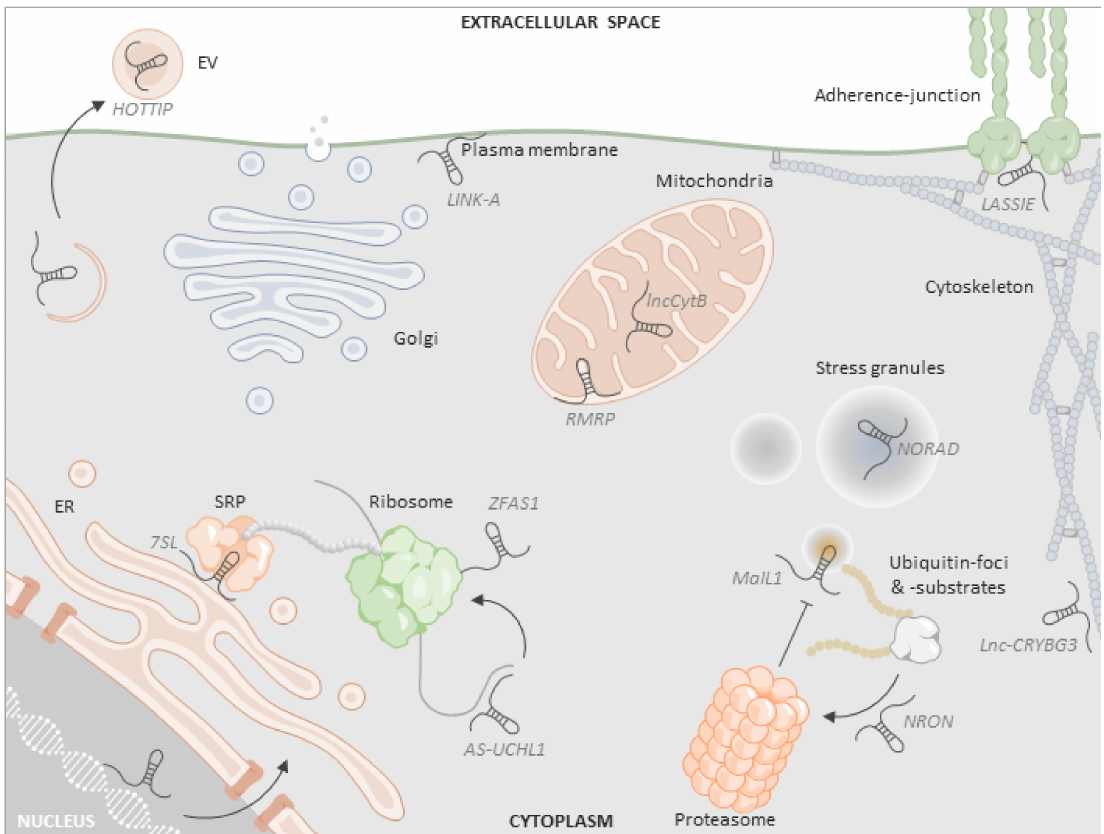
Figure 1. Exemplary illustration of lncRNAs in cytoplasmic structures and machineries. Many lncRNAs are exported from the nucleus and subsequently shuttled to specific cytoplasmic